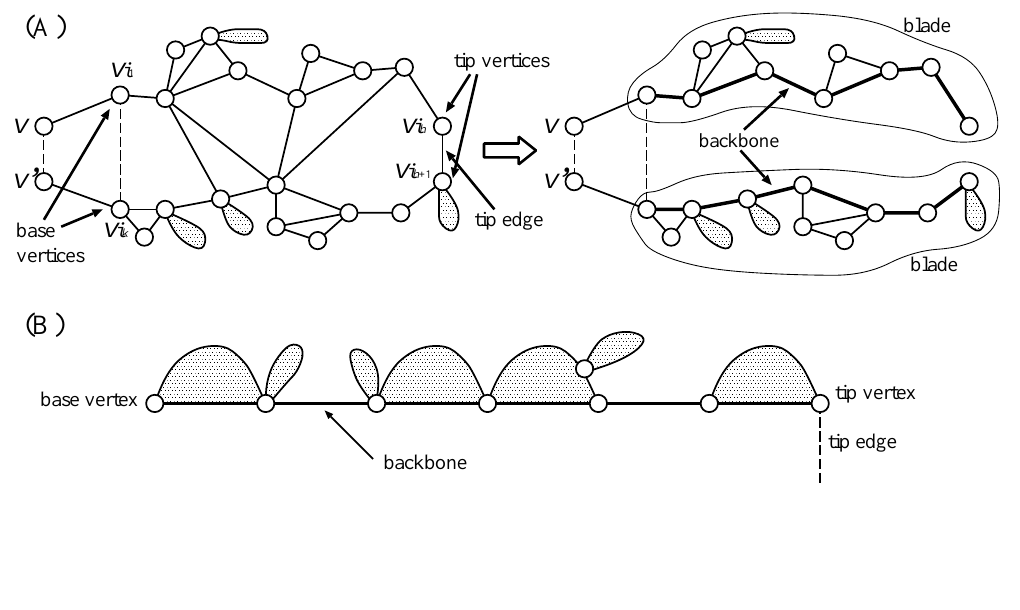
Figure 6. ( A ) Construction of blades where subgraphs, excluding gray regions (descendant components), are blade bodies; and ( B ) schematic illustration of a